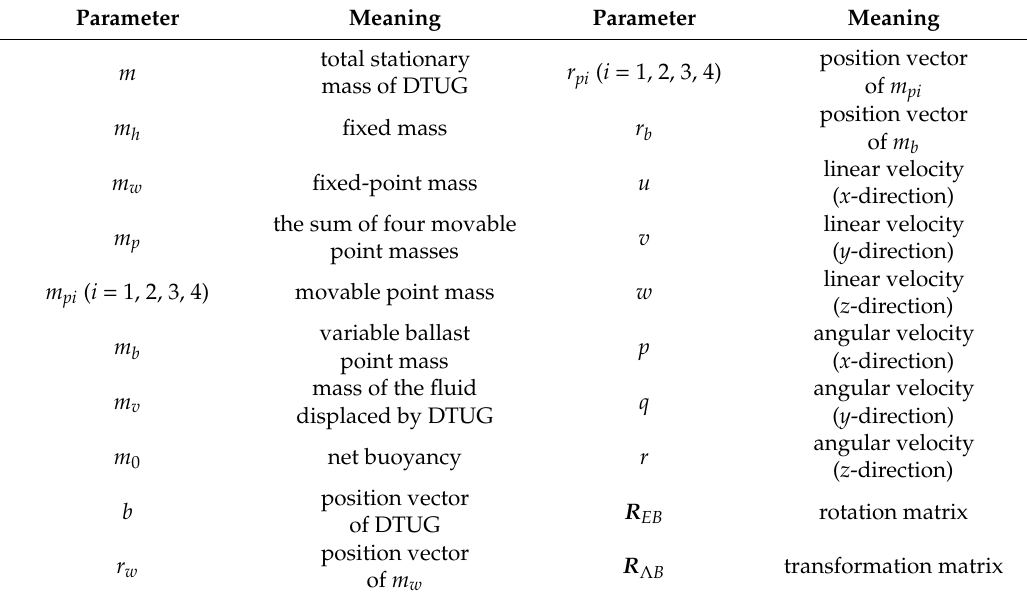
Table 1. Main parameters of the